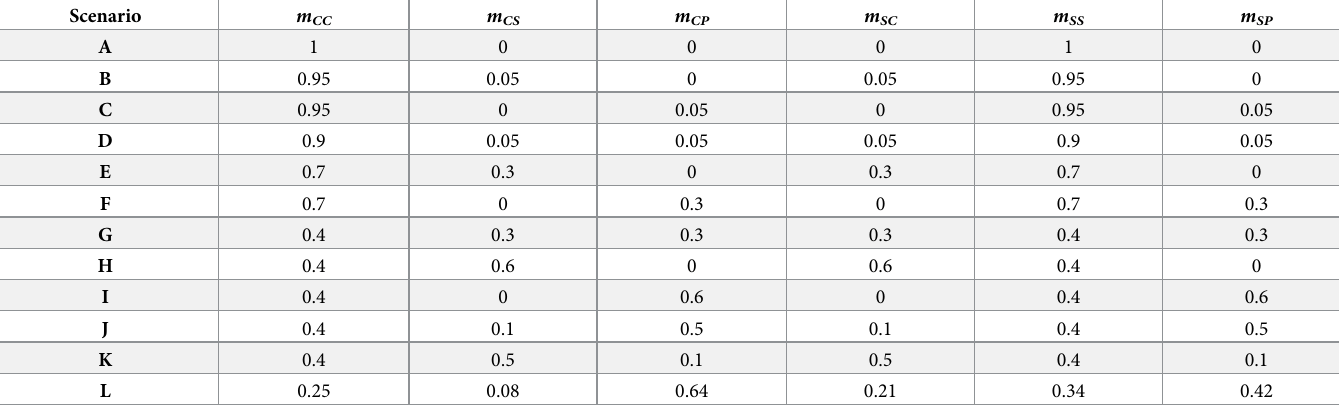
Each simulated scenarios assumes a different set of six pairwise male gametic gene flow rates ( m ), with the first and second subindexes of m indicating the recipient and source population, respectively, with codes C (calcareous natural population), S (siliceous natural population) and P